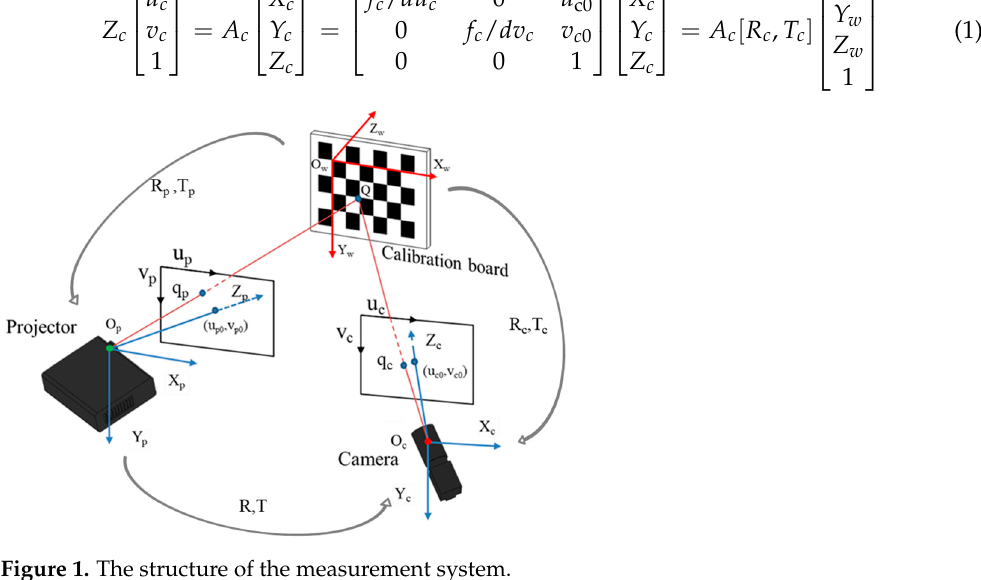
Figure 1. The structure of the measurement system.